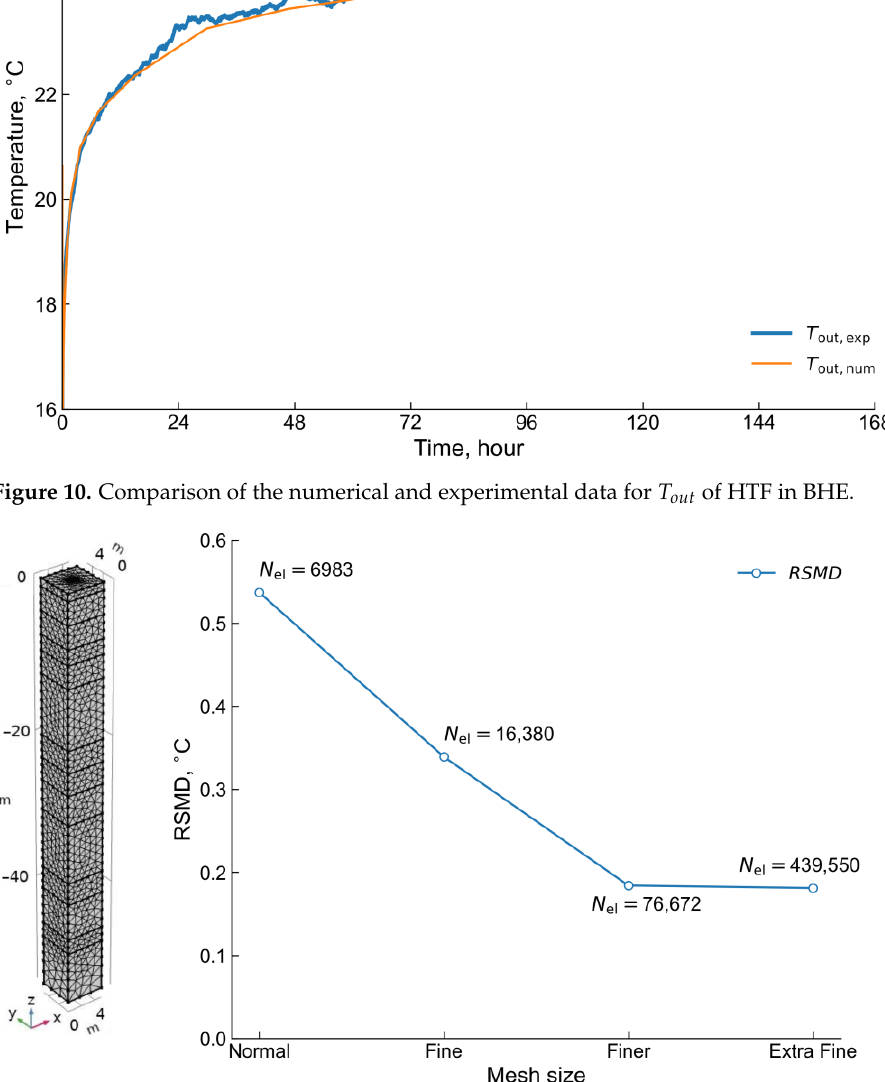
Figure 11. Grid sensitivity analysis.